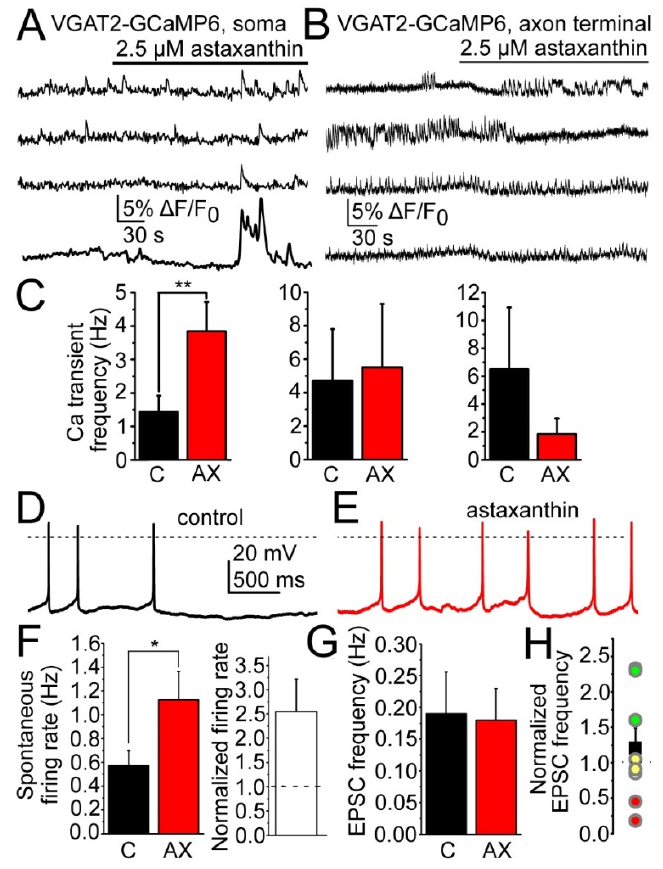
Figure 5. Changes in the excitability of the synaptic currents of the GABAergic inhibitory neurons of the arcuate nucleus. ( A , B ) Representative average calcium imaging traces from four GABAergic somata under control conditions and with application of 2.5 µM AX. ( C ) Statistical comparison of the calcium transient frequency of the GABAergic somata in control and with AX (black, C: control, red, AX) in the neuronal groups where increase, no change or decrease was seen (from left to right, respectively). Increase was seen in 77.3%, no change was observed in 9.1% and decrease was detected in 13.6% of the neuronal somata; ( D , E ) spontaneous activity of GABAergic neurons in control (black) and with AX (red); ( F ) statistical comparison of the spontaneous and normalized firing rate under control conditions and with AX (black, C: control, red, AX); ( G ) statistical representation of EPSC frequency in control (black, C) and with astaxanthin (red, AX); ( H ) average frequency change (black square) and frequency changes of the individual cases (green: increase, red: decrease, yellow: no change). * p < 0.05, ** p < 0.01.